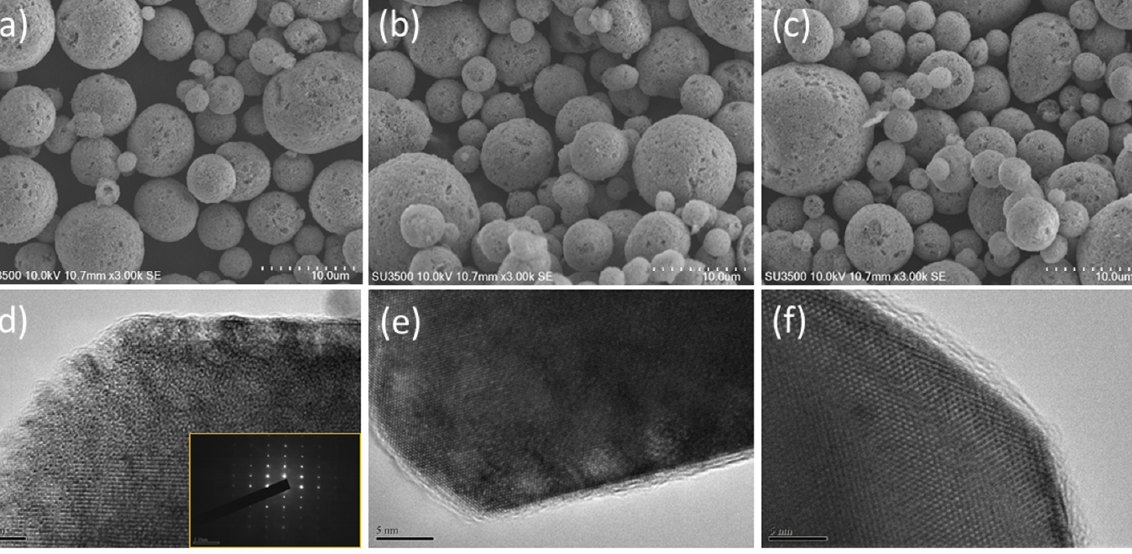
Figure 6. The SEM morphology of ( a ) bare LTO; ( b ) PO-LTO and ( c ) POP-LTO; the transmission electron microscopy (TEM) image of ( d ) bare LTO; ( e ) PO-LTO and ( f ) POP-LTO.